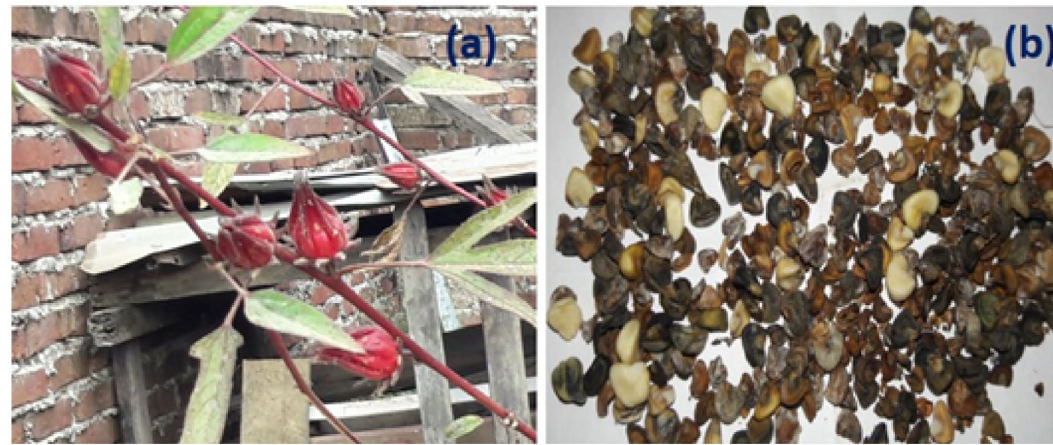
Figure 2. Roselle plant and seeds. Mode Fuel used